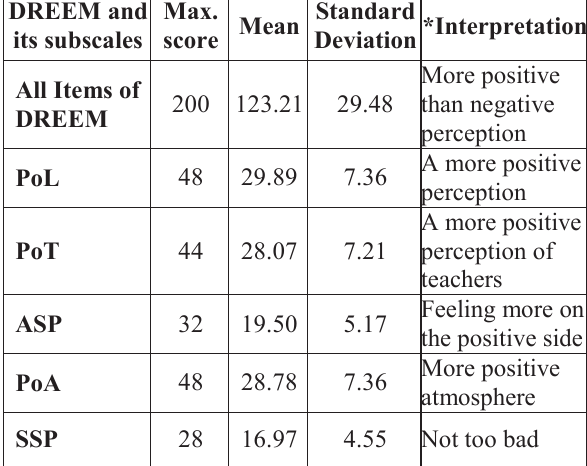
Table-3: Descriptive Statistics of Scores.